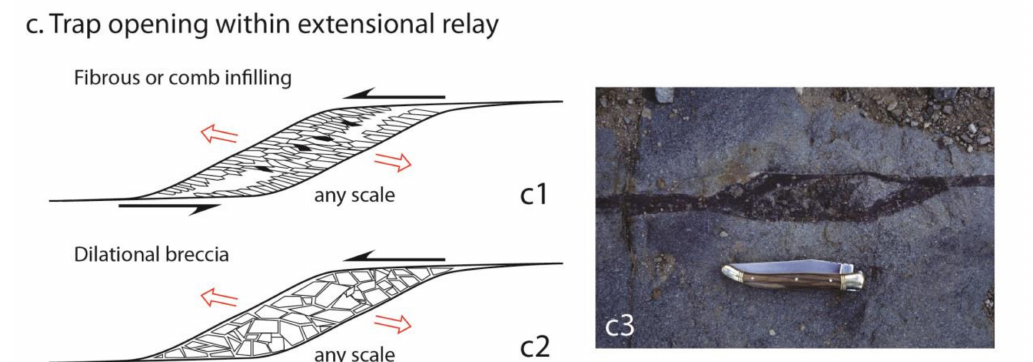
Figure 1. Three examples of traps and voids mode of formation. ( a ) Model of formation of sigmoidal veins by antithetic bedding-controlled gliding during fold development ( a1 ). Example from the Bourg-d’Oisans area ( a2 ). ( b ) Stockwork formation in accommodation of shearing affecting some multi-layers rocks with contrast of competence ( b1 , b2 and b3 ). Conceptual sketch ( b4 ) in which yellow veins represent the stockwork formed in more competent layers. ( c ) Trap opening within left lateral pull-apart ( c3 ). The two sketches c1 and c2 illustrate the process and show the two types of filling encountered within these structures. See text for